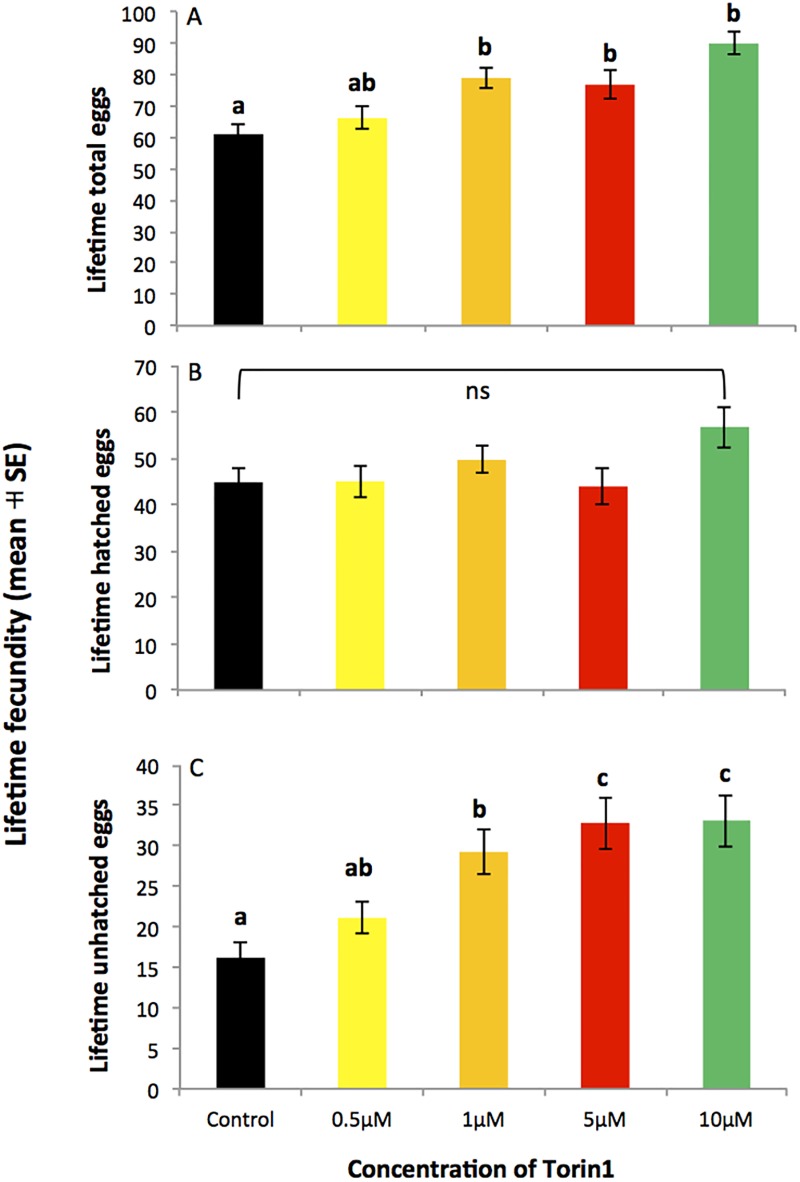
Effect of Torin1 on lifetime fecundity of once-mated females shown in Fig 1.Lifetime egg production (mean ± SE) of once-mated females exposed to DMSO carrier control, 0.5 μM, 1 μM, 5 μM or 10 μM Torin1. (A) total lifetime fecundity, (B) lifetime number of hatched eggs, (C) lifetime number of unhatched eggs. Letters not in common indicate a significant difference between groups (Tukey post hoc test, p < 0.05). ns = not significantly different (p > 0.05).